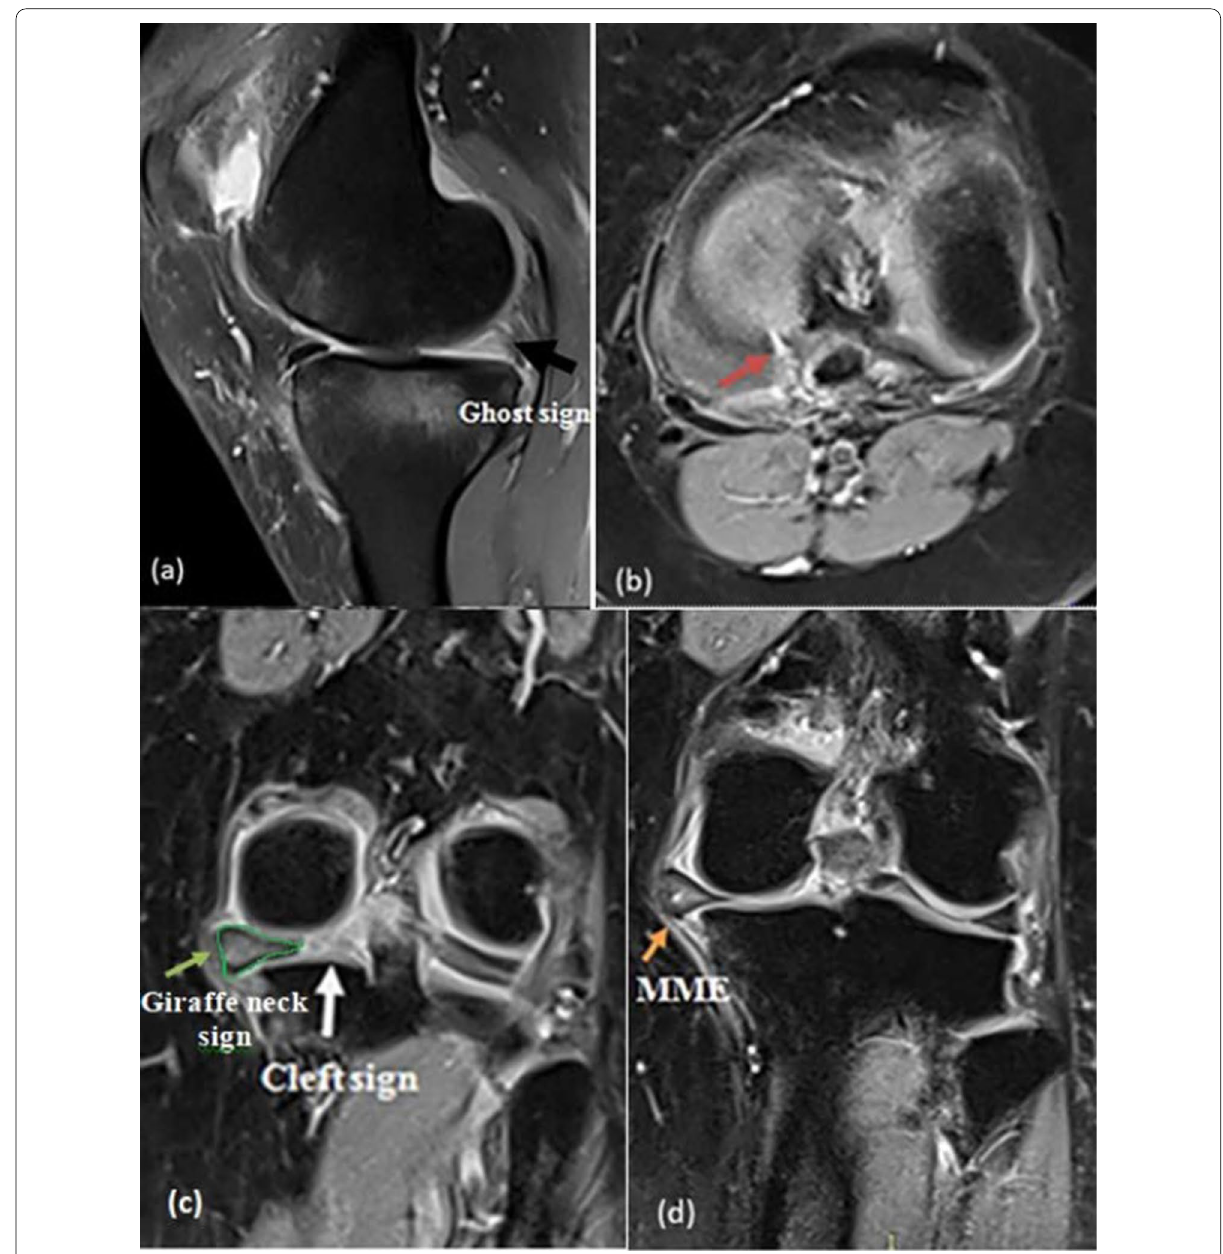
Fig. 3 Characteristic signs of the MMPRT on the MR images (PD‑SPAIRWI). A 63‑year‑old woman (the left knee) showed: a A ghost “white meniscus” sign (black arrow) at the sagittal view. b A radial tear sign adjacent to the MM posterior root (red arrow) is seen as a linear fluid gap defect at axial coronal view